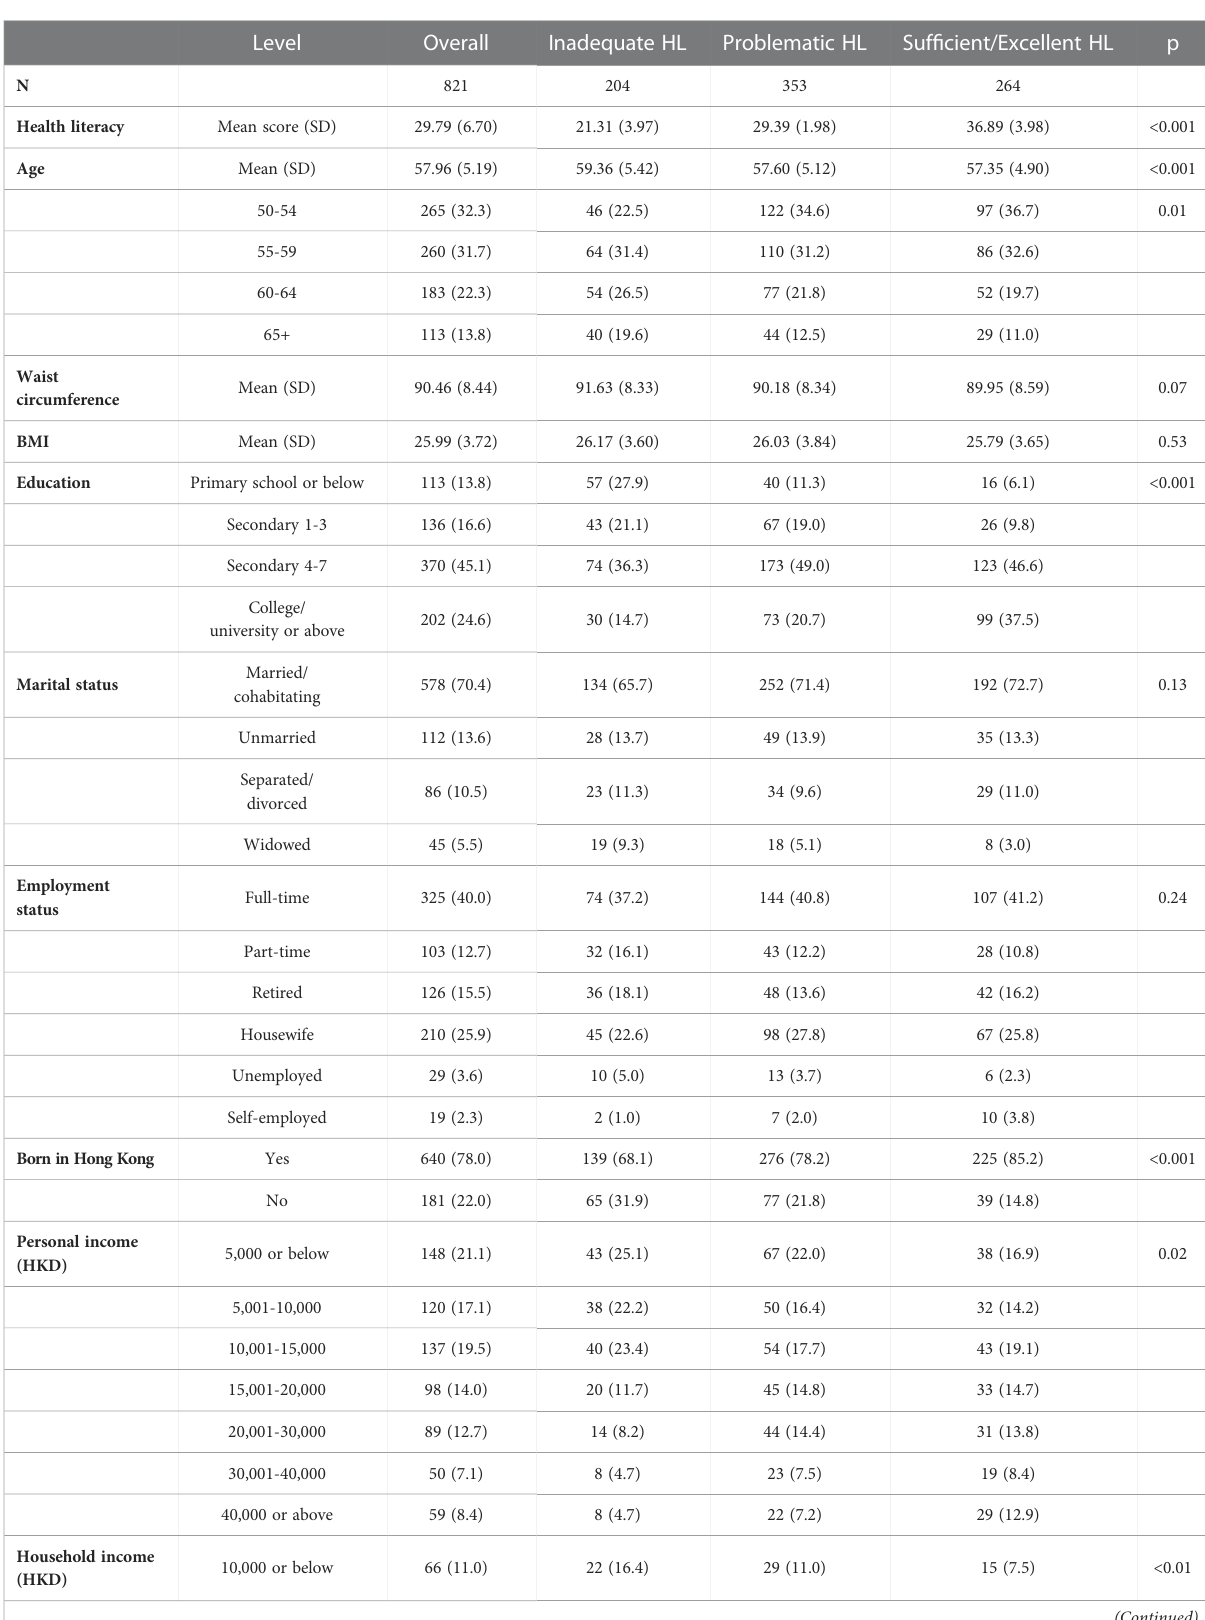
TABLE 1 Characteristics of individuals by health literacy